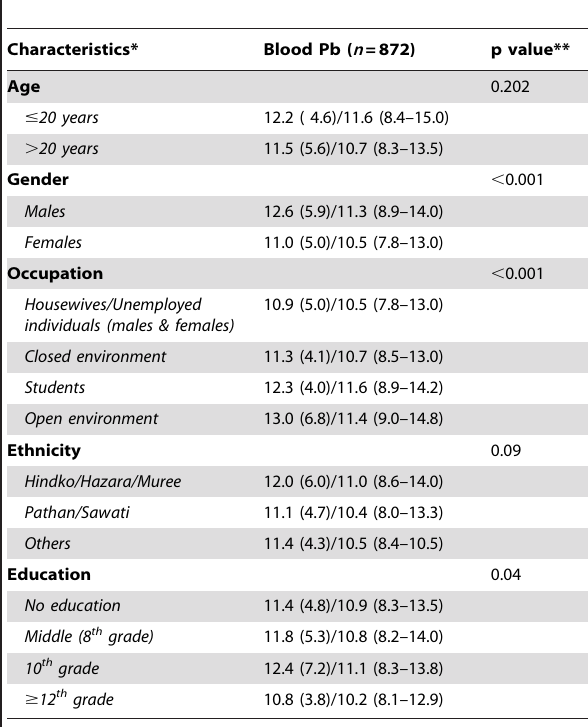
Table 1. Demographic characteristics versus mean/median blood Pb levels in Pakistani adults.